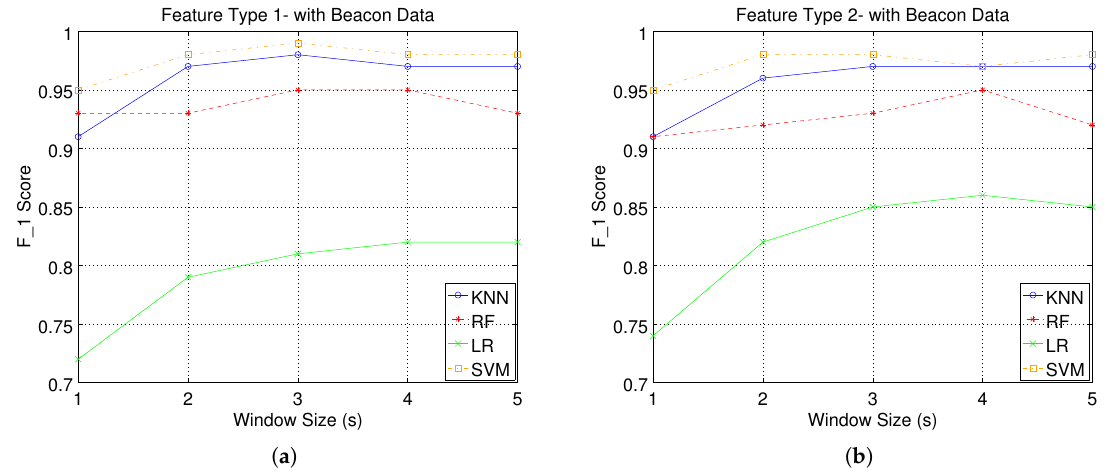
Figure 8. Activity recognition system performance with beacon data: weighted average of F 1 score over all activities, for different window sizes, feature types and classification models. ( a ) Wearable Feature Type 1 (mean, standard deviation); ( b ) Wearable Feature Type 2 (mean, standard deviation, mean crossing rate, maximum and